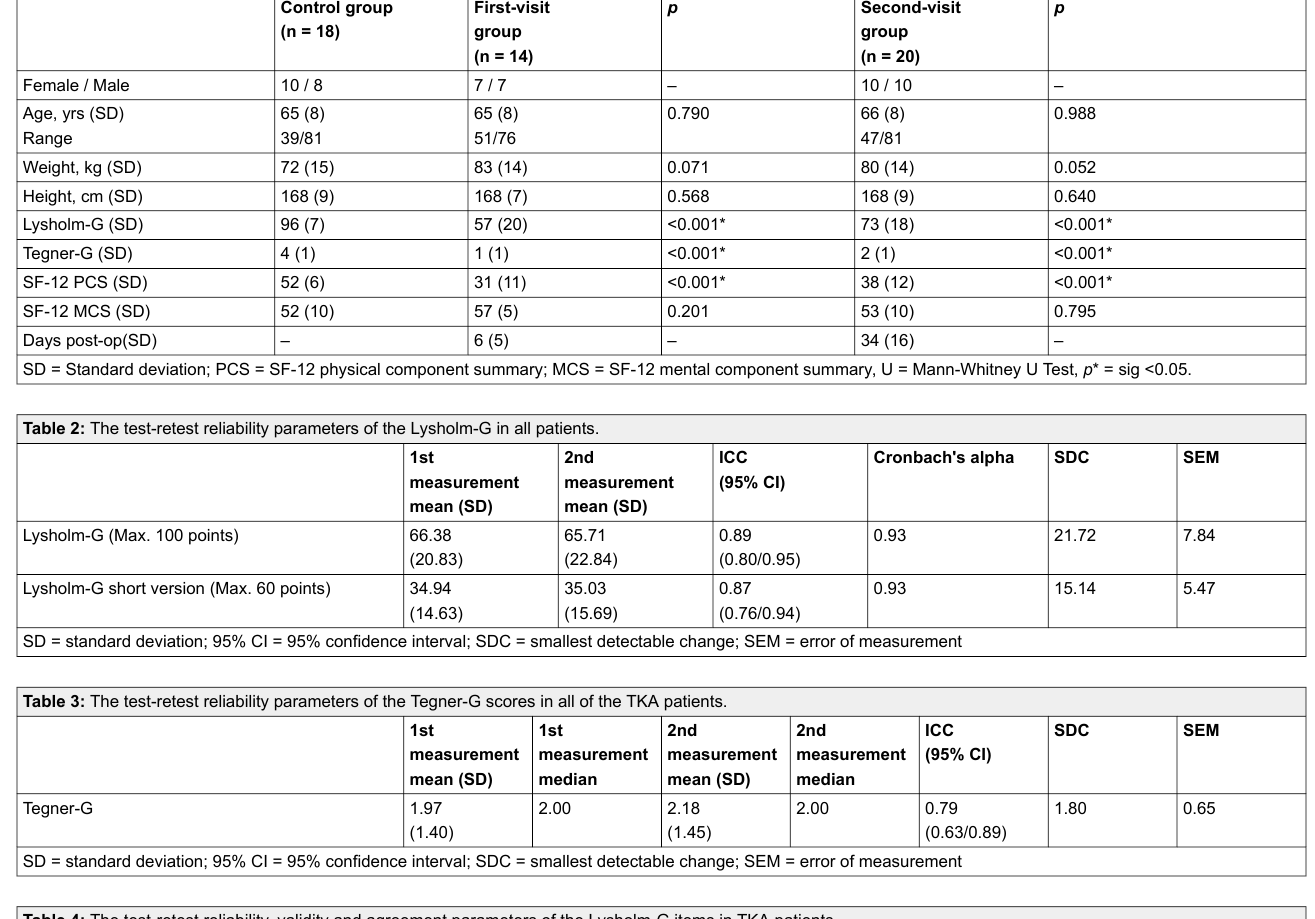
Table 4: The test-retest reliability, validity and agreement parameters of the Lysholm-G items in TKA